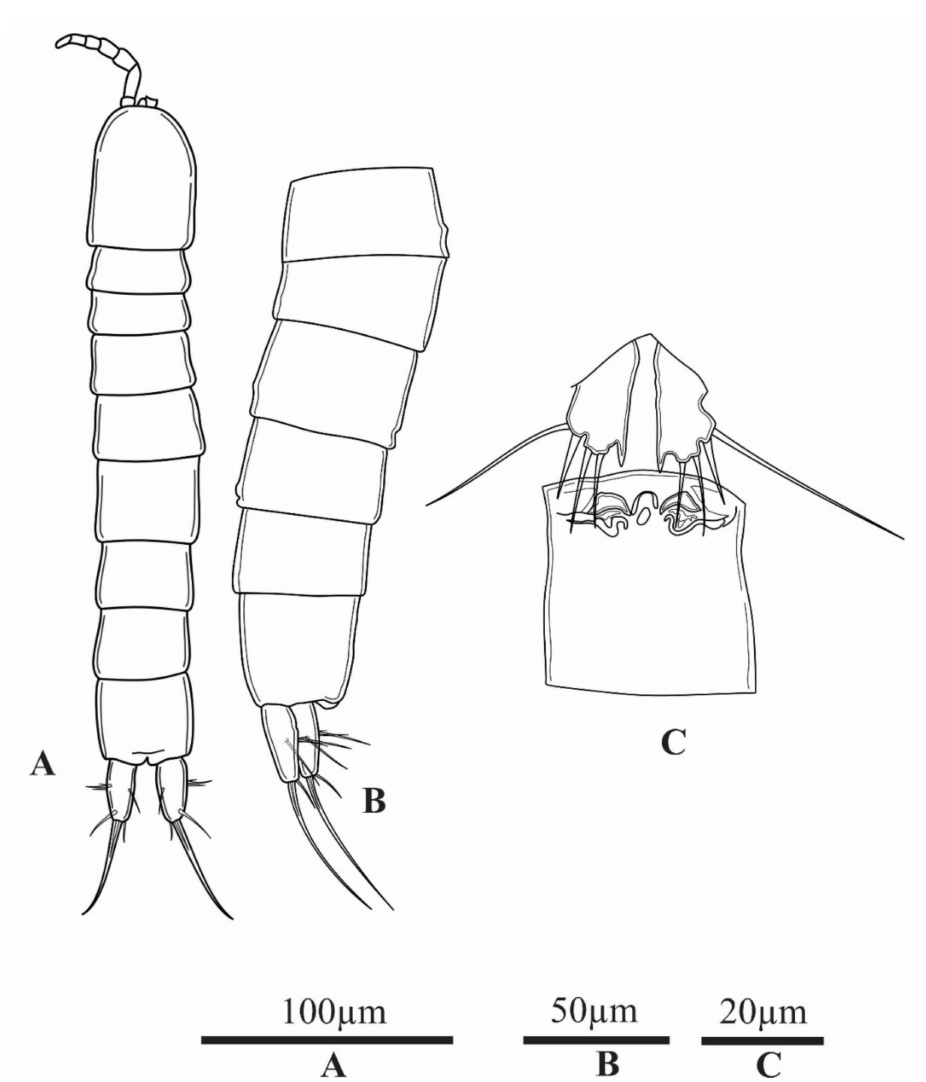
Figure 1. Parastenocaris sontraensis sp. nov. holotype female. ( A ), habitus dorsal view; ( B ), urosome lateral view; ( C ), P5 and P6 and genital